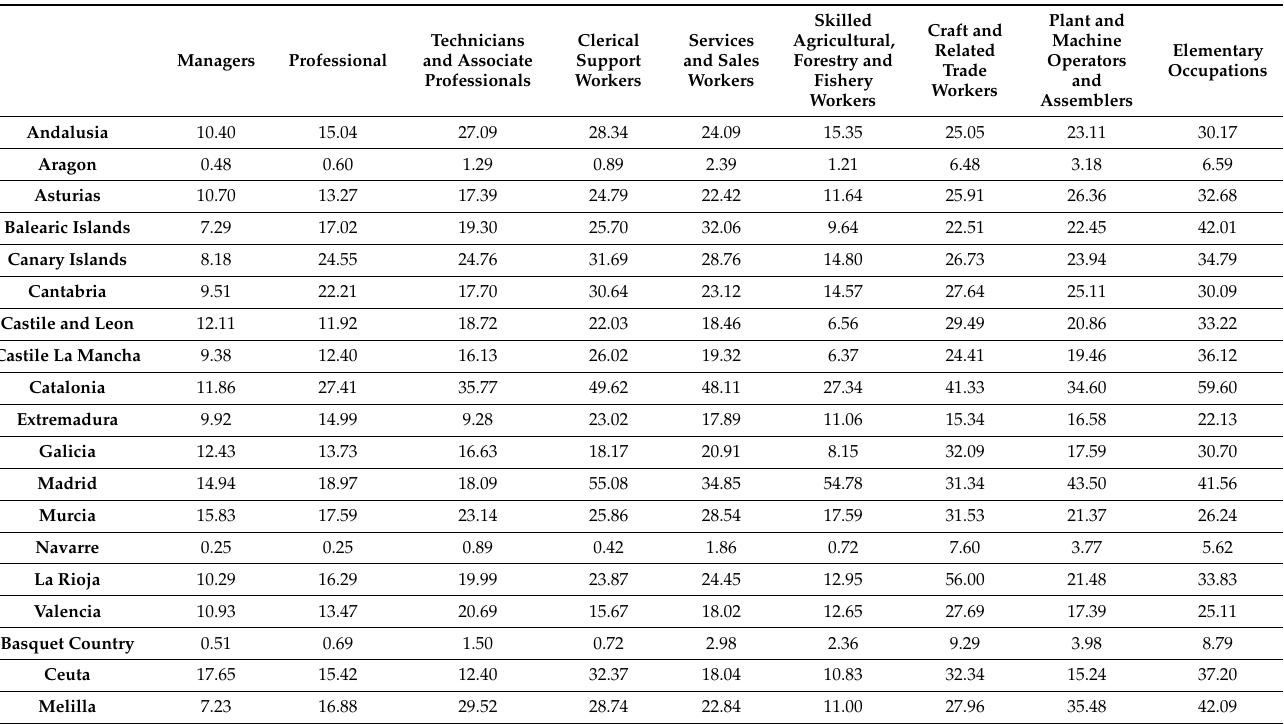
Table 1. Sickness absences rates according to occupational group (ISCO-08) and Autonomous Communities (2019).